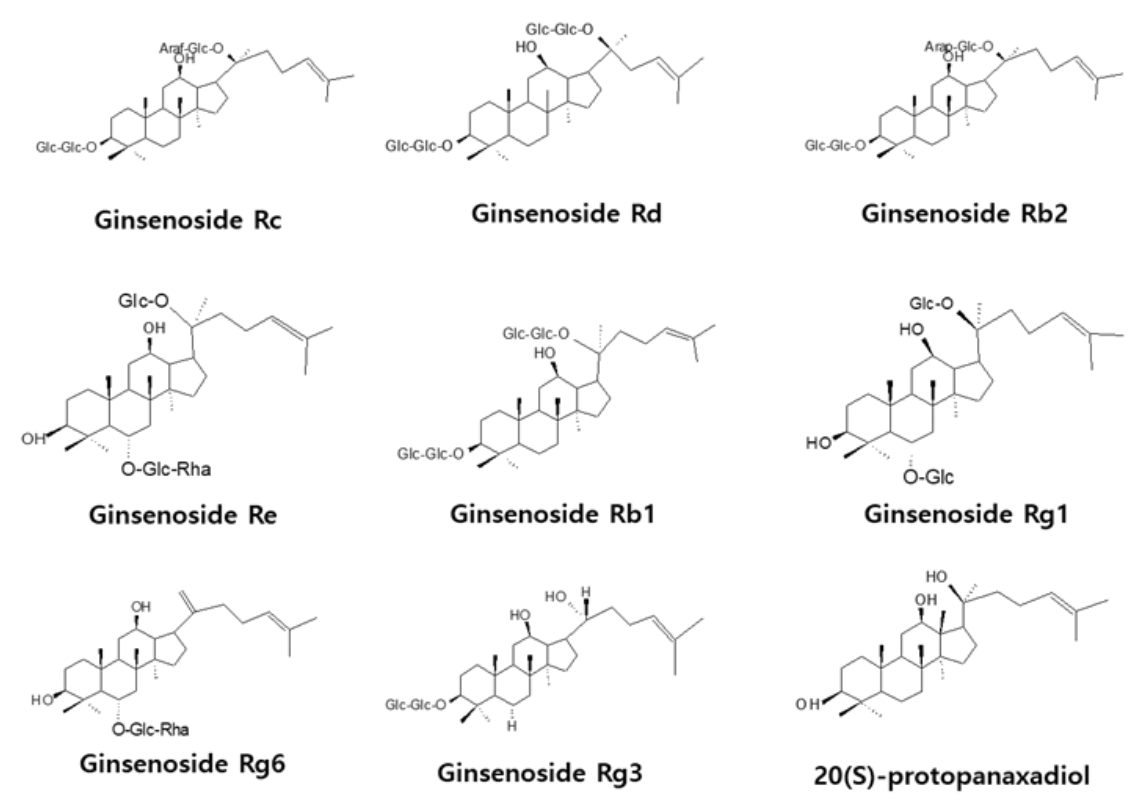
Figure 2. Chemical structures of ginsenosides and aglycone.